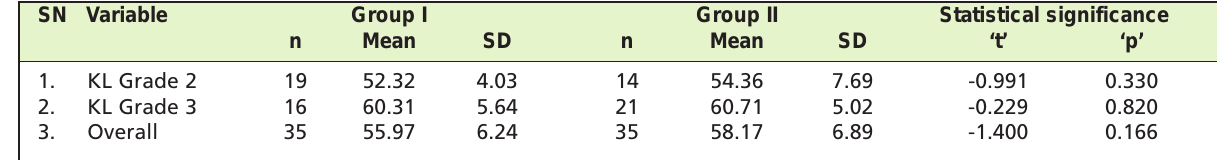
Comparison of two groups according to Pre-intervention WOMAC scores Table III: